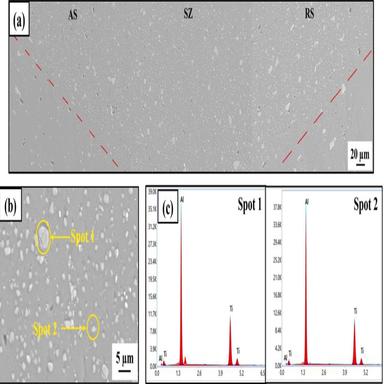
SEM micrographs of WR_3 material (a) Stitched images showing cross-sectional microstructure of WR_3 material at various FSP processed zones (b) Enlarged view of the stir-zone (SZ) (c) EDS analysis of the spots in the SZ.